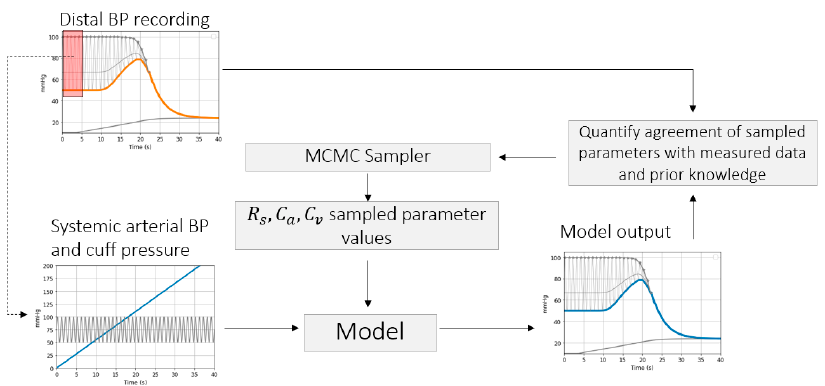
Figure 3. Sampling process to be repeated over a number of iterations to determine the posterior distribution of model parameters.